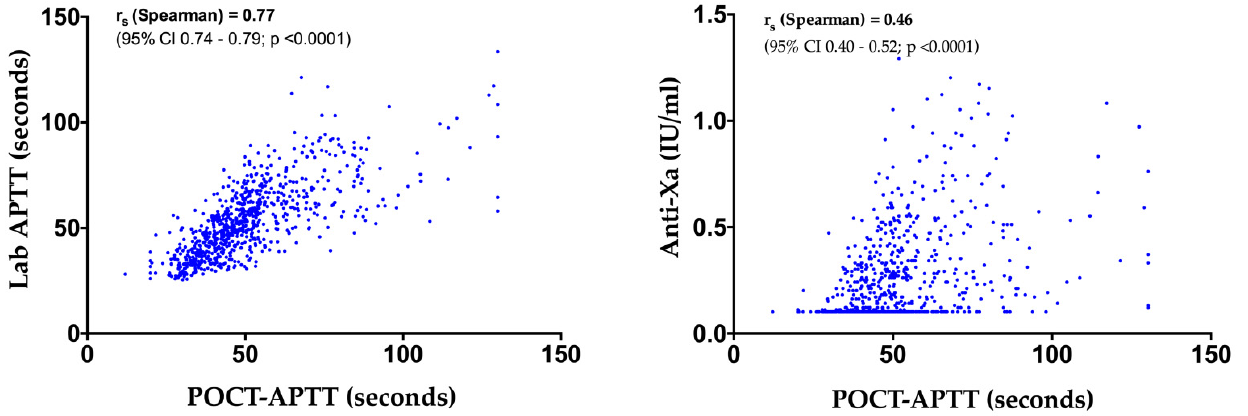
Figure 2. Overall correlation of POCT-APTT vs. laboratory APTT ( left panel, n = 795) and POCT- APTT vs. anti-Xa ( right panel, n = 729) from the 35 patients included in the study.